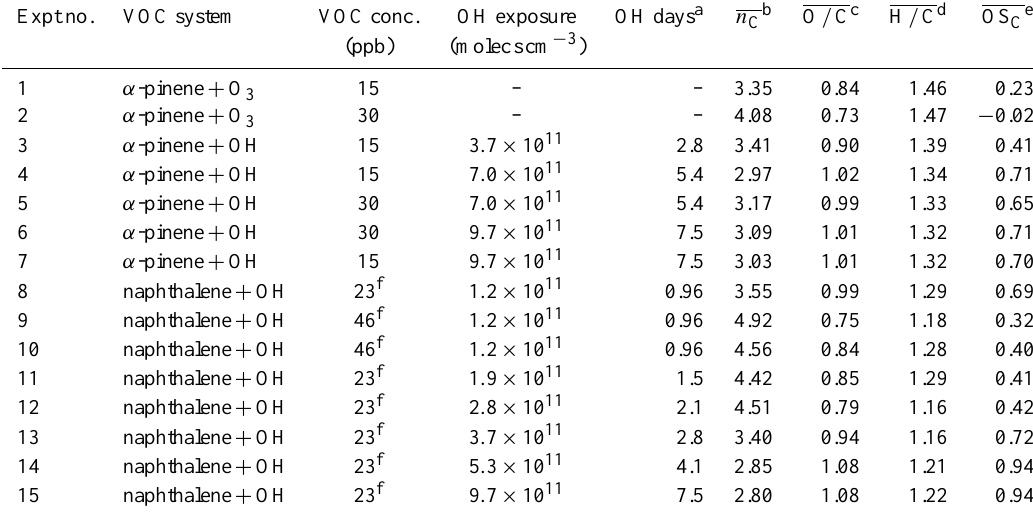
Table 1. Experimental conditions and results.